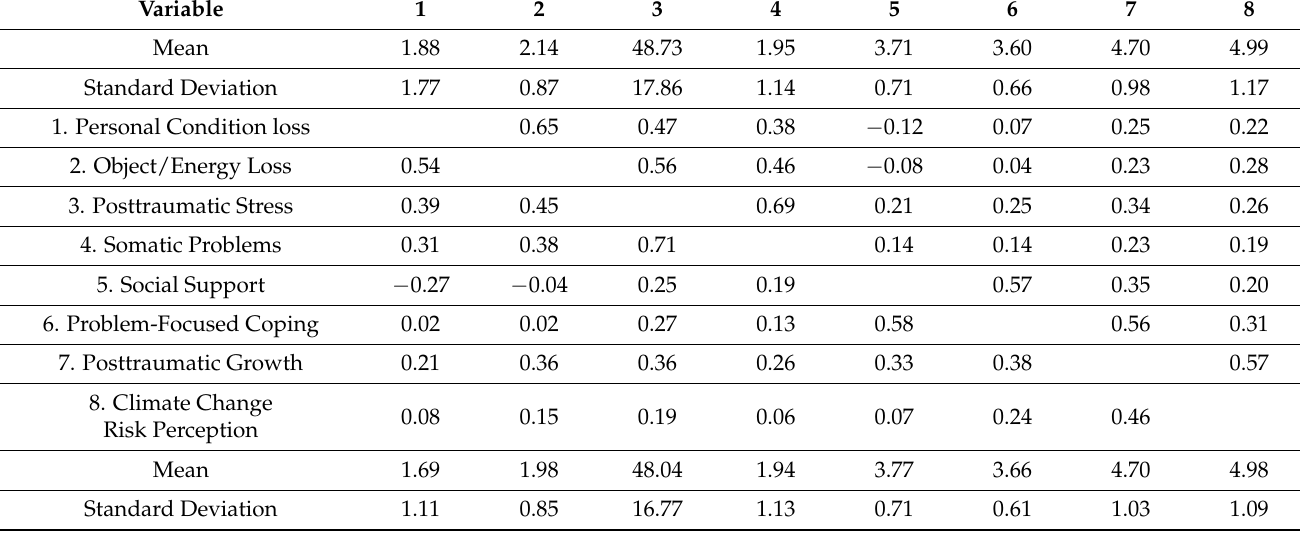
Table 1. (Study 1: Philippines) . Means, Standard Deviations, and Correlations between Measured Variables for Initial Sample ( N = 160) and Confirmatory Sample ( N =